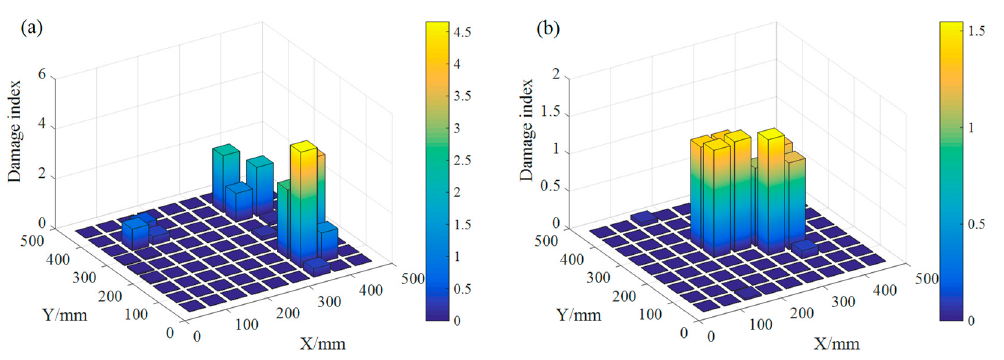
Figure 4. Damage index map with random noise: ( a ) damage case 1 and ( b ) damage case 2.